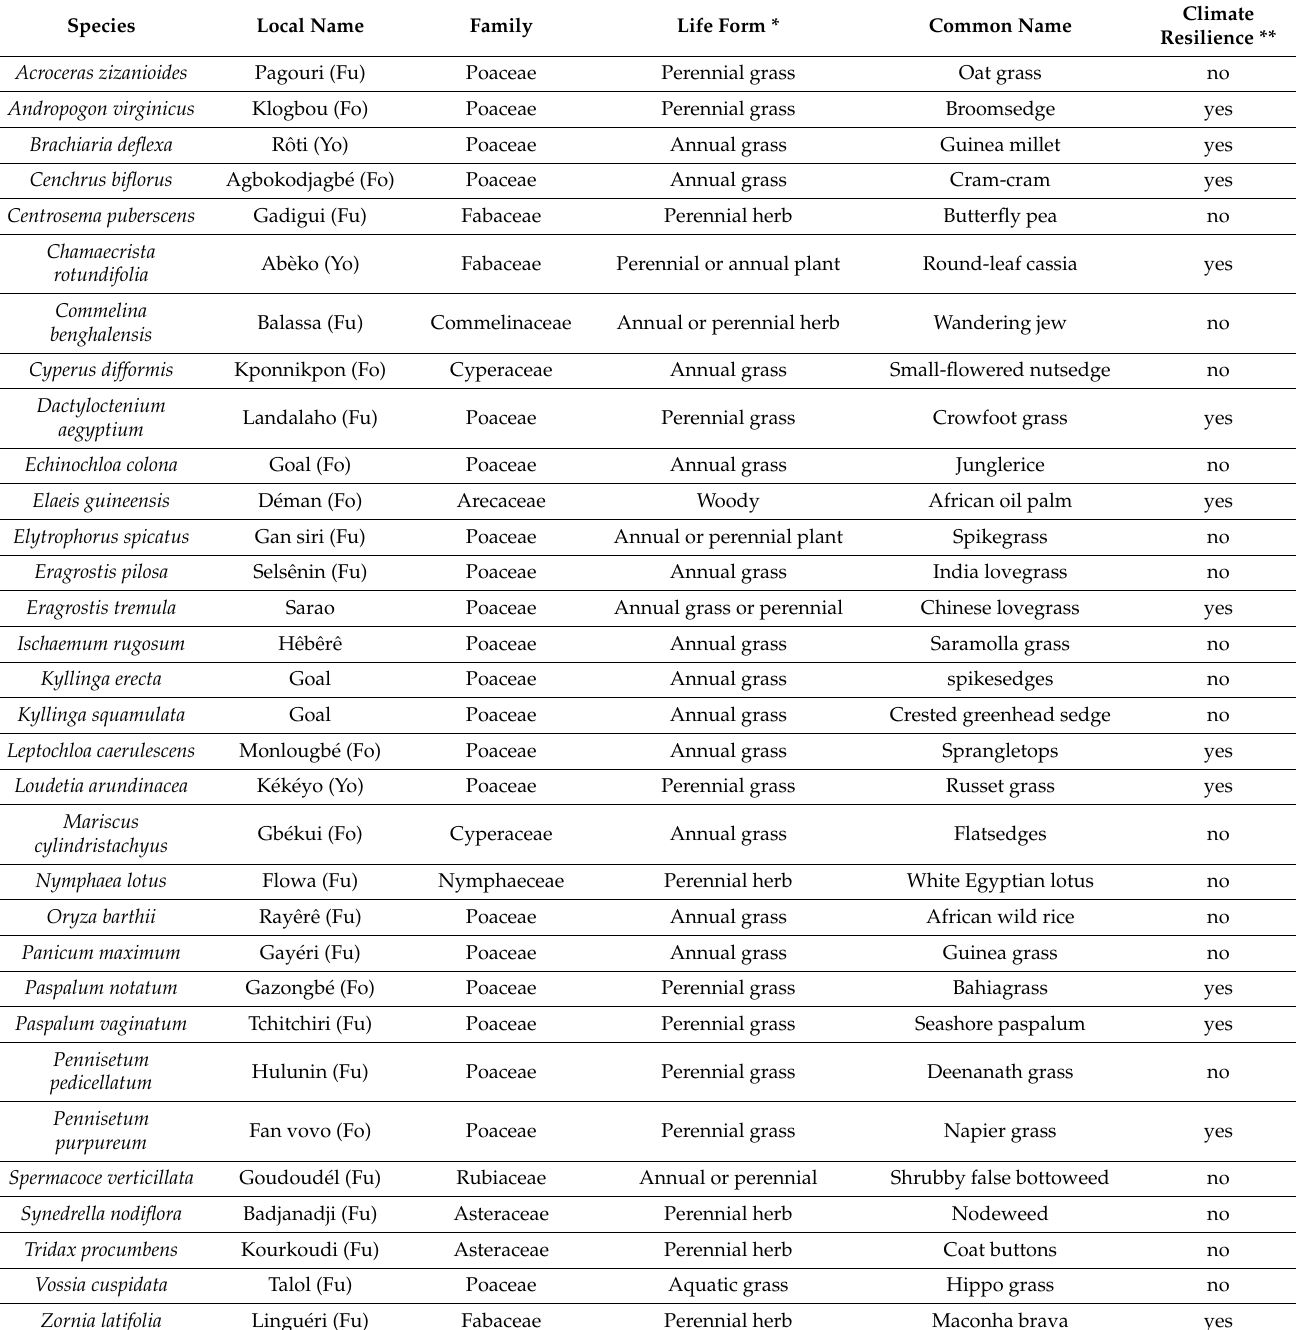
Table 1. Forage species consumed by cattle during the dry season along the coastal region of Benin.